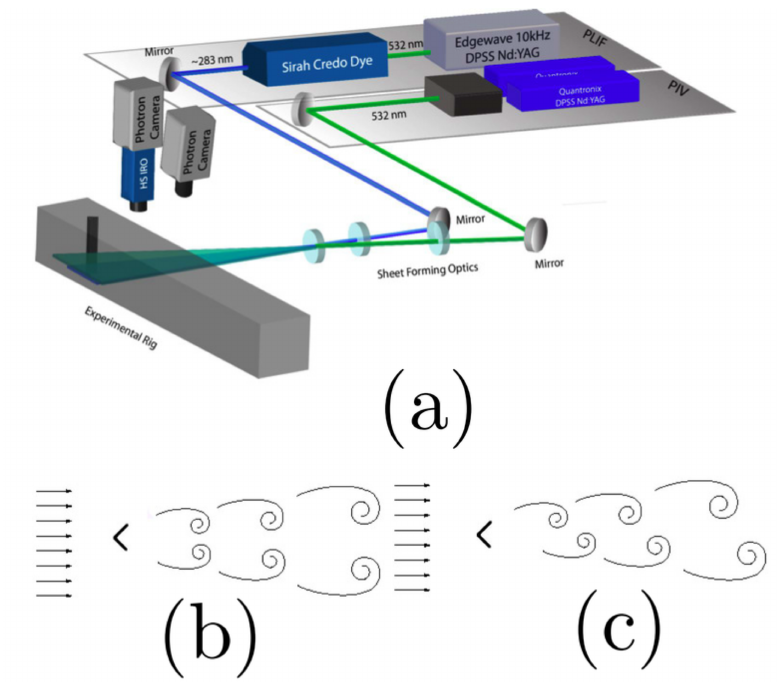
Figure 2. ( a ) Schematic of the reacting flow behind a v-gutter bluff body (adapted from the Ref. [38]). Schematics showing ( b ) symmetric and ( c ) von Karman vortex shedding behind a symmetric